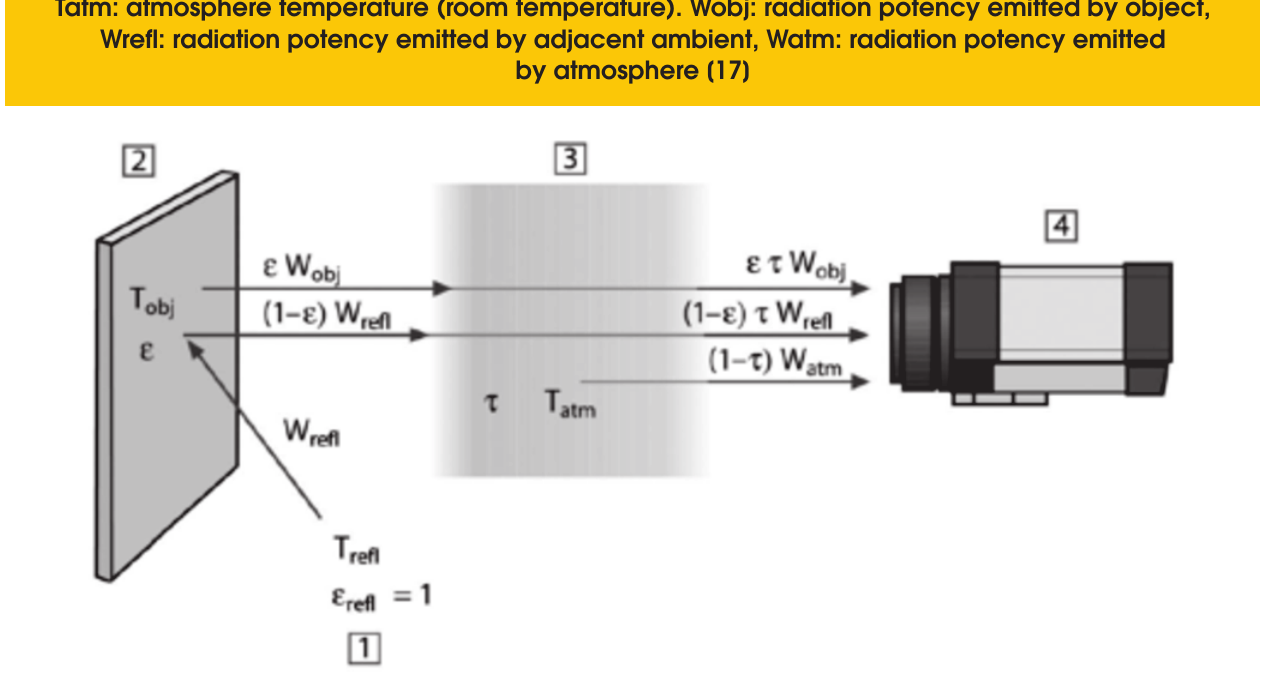
Figure 1 – Schematic representation of a thermographic measurement. 1) adjacent ambient, 2) object, 3) atmosphere, 4) camera. Tobj: object's temperature, Trefl: reflected temperature, Tatm: atmosphere temperature (room temperature). Wobj: radiation potency emitted by object,